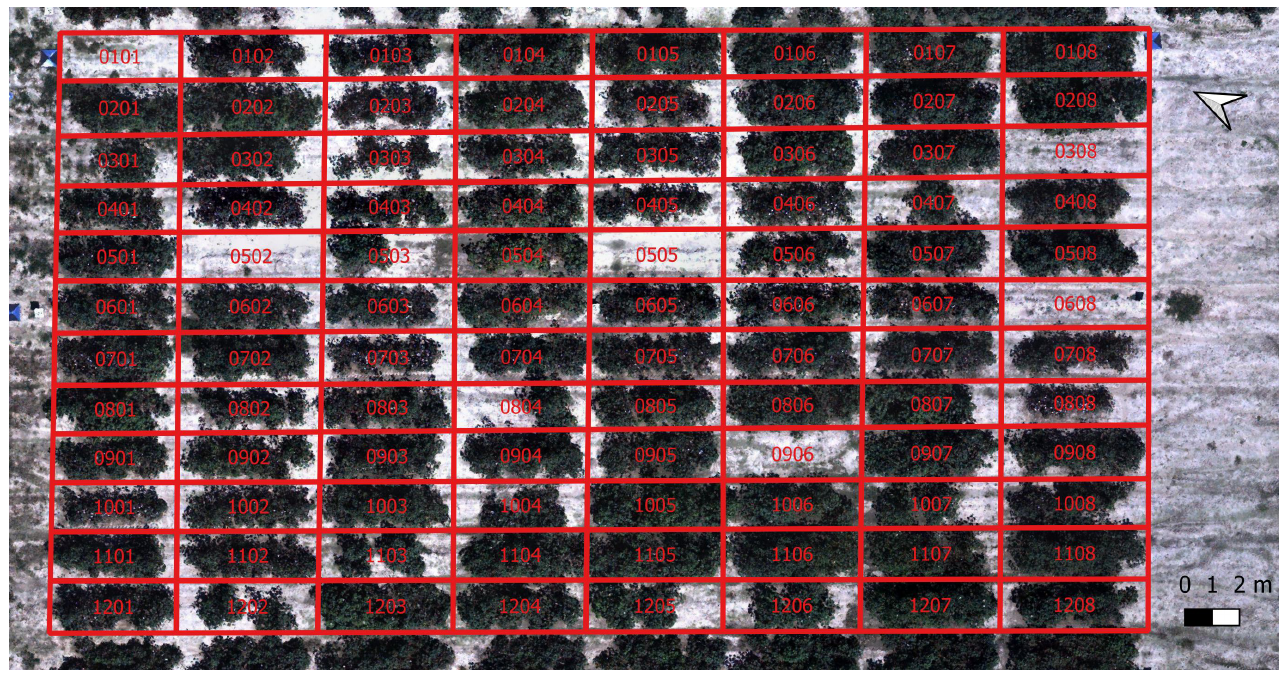
Figure 8. Testing field